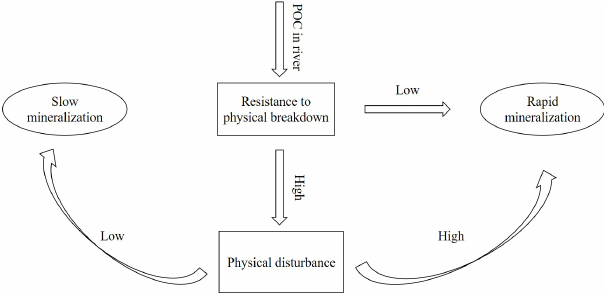
Figure 8. Conceptual figure representing the effect of physical dis- turbance on SOC decomposition upon entering river